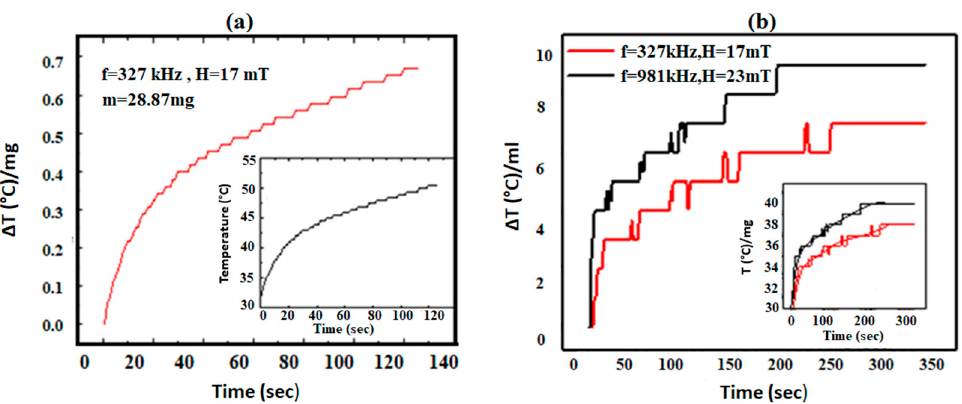
Figure 7. ( a ) Magnetic hyperthermia measurements were taken on CoFe 2 O 4 nanoparticles (sample 1) displayed as a temperature change ∆ T of a sample per milligram and ( b ) Magnetothermia measurements on sample 3 represented as a change in temperature ∆ T per ml of the dispersion. The inset shows the original heating curves. Solid lines are guided to the eye.